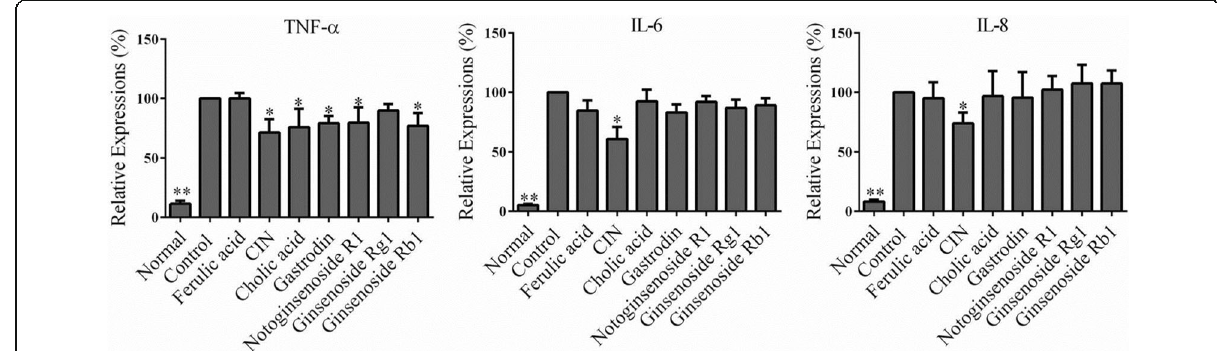
Fig. 6 Effect of single pure compounds on the expression of TNF- α , IL-6 and IL-8 in LPS-stimulated MH7A cells. *p < 0.05 , **p < 0.01 vs . control group